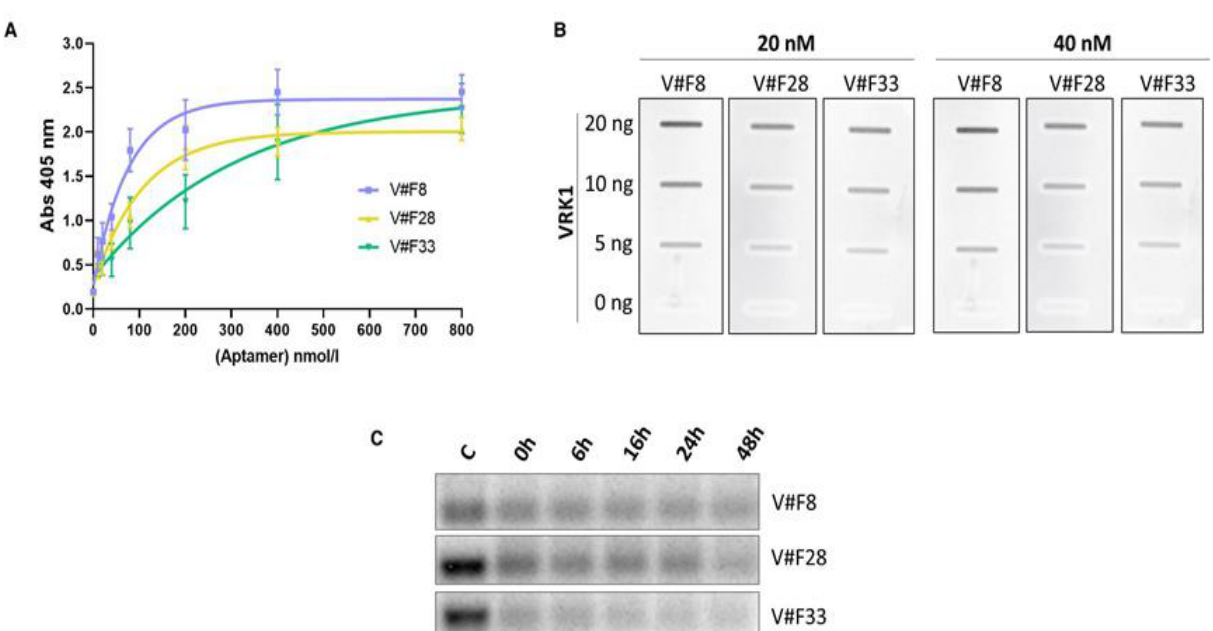
Figure 3. Characterization of VRK1 aptamers. ( A ) ELONA assays to determine the binding affinity of the aptamers to VRK1. The recombinant VRK1 protein was plated at 20 ng/well and then incubated with the digoxigenin-labeled aptamers at increasing concentrations (0 – 800 nM). All the experiments were performed in triplicate and an average ± SEM of 3 – 5 different experiments is shown. ( B ) Slot blot in which increasing amounts of VRK1 protein (0 – 20 ng) were fixed under a vacuum to a nitrocellulose membrane and incubated with digoxigenin-labeled aptamers at 20 and 40 nM. Afterwards, the membrane was probed with anti-digoxigenin-POD, developed with an enhanced chemiluminescence kit and exposed to hyperfilm. The membrane shown is representative of three different experiments. ( C ) Aptamer susceptibility to enzymes in plasma. Representative agarose gels are shown.